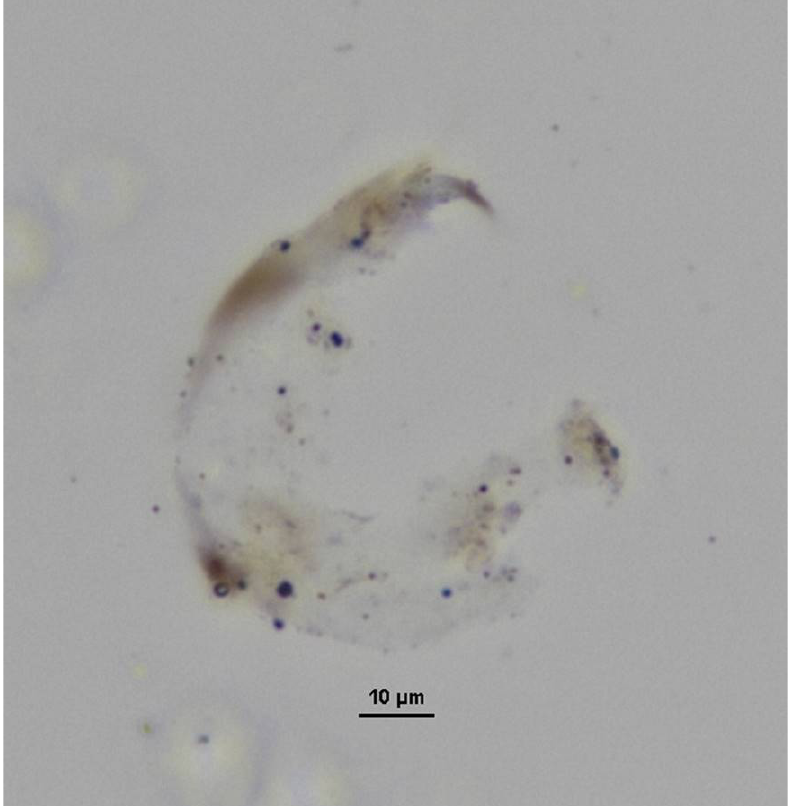
Figure 13. Recovered cooking or parching damaged starch grain: transmitted light. Artefact 6, point sample 2 at